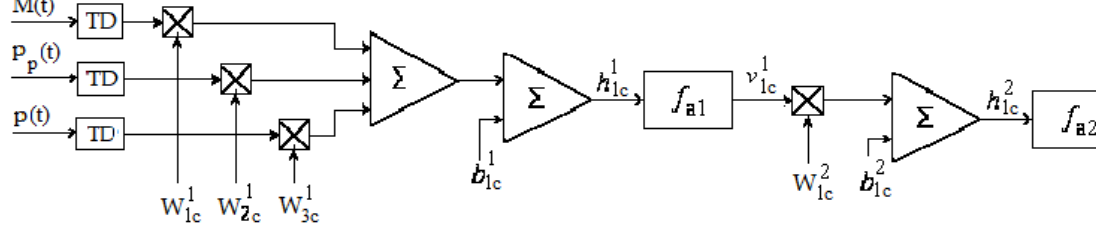
Figure 17. Block diagram of neural